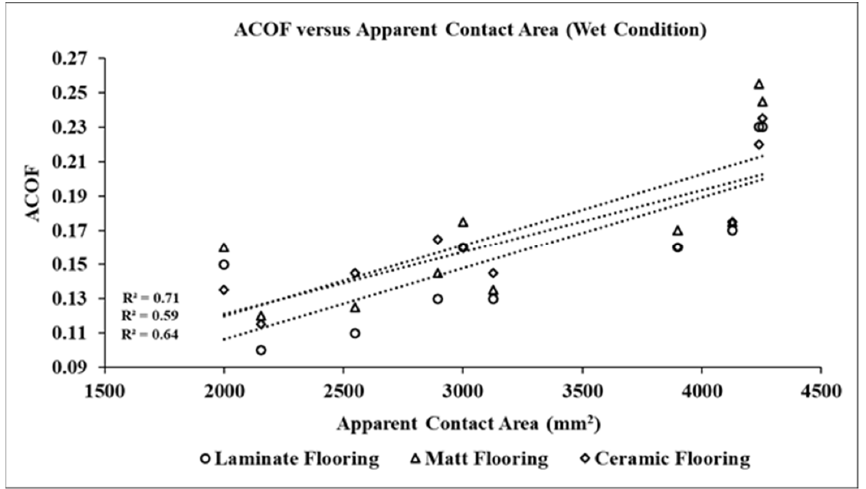
Figure 8. Correlation between apparent contact area and ACOF across tested shoes in wet condition.